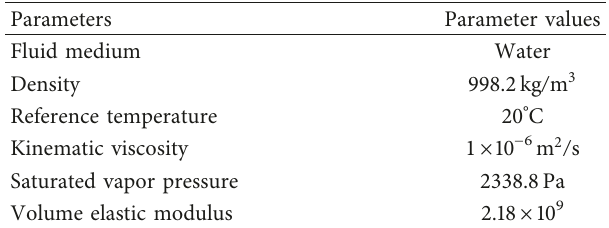
Table 6: Influence analysis of parameters on the